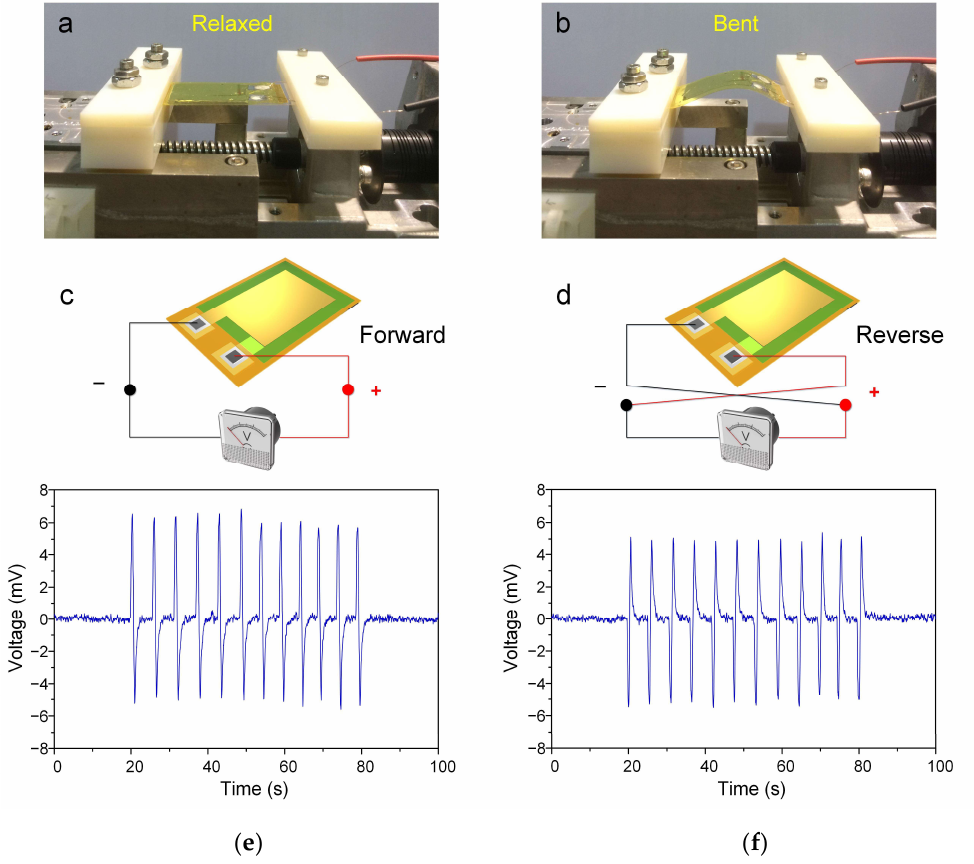
Figure 7. Photographs of AlN-PNG in its ( a ) original state and ( b ) bent state by the linear motion stage; schematic illustration of the open-circuit voltage measurement in ( c ) forward and ( d ) reverse connections; generated voltage from AlN-PNG under periodic bending in ( e ) forward and ( f ) reverse connections.